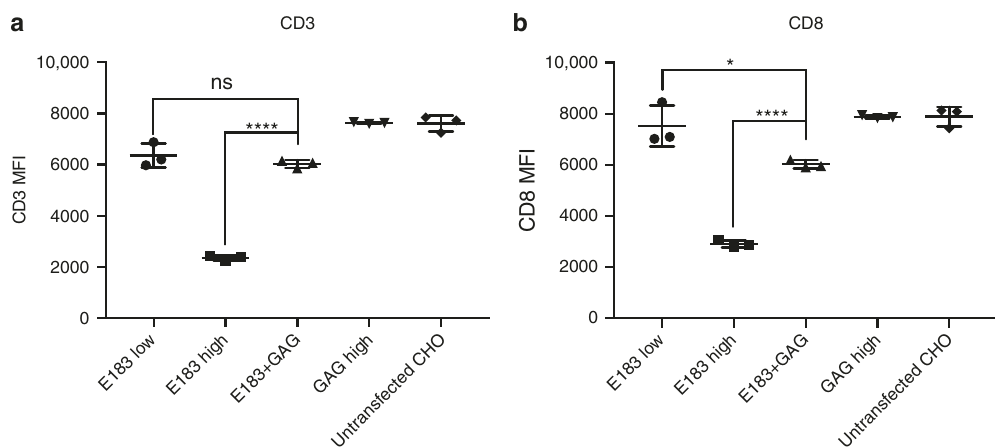
Fig. 6 CD3 and CD8 are not strongly downregulated in coagonism. Anti-CD3 ( a ) and anti-CD8 ( b ) staining were performed in human CTL activation experiments stimulated by the indicated T-REx CHO clones. CD3 and CD8 amount were then assessed by fl ow cytometry. Data are representative of three independent experiments. MFI mean fl uorescence “ No pMHC ” control. Compared to low concentration of